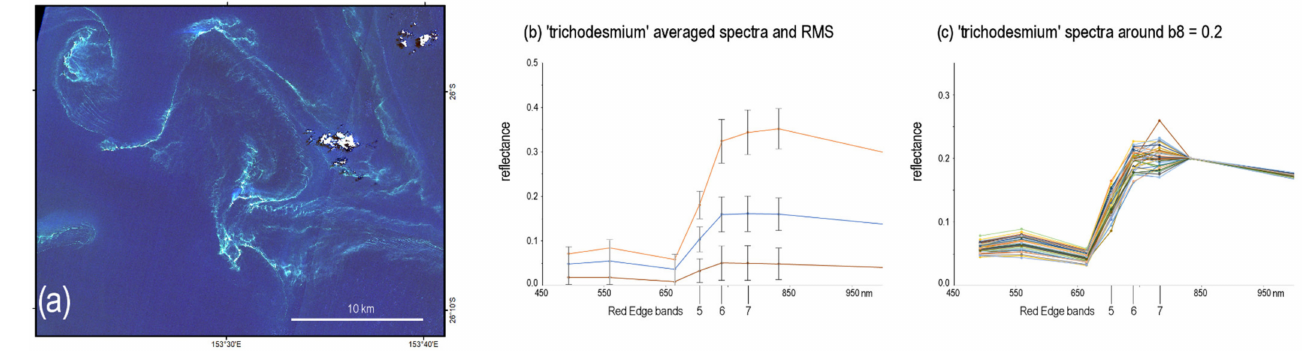
Figure 11. ( a ) “Trichodesmium” cyanobacteria bloom detected on 11 November 2020 off Gold Coast (QLD), eastern Australia (Sentinel-2 tile: T56JNS). ( b ) Averaged spectra and RMS around b8 = 0.35, b8 = 0.15 and b8 = 0.05. ( c ) Pixel spectra around b8 = 0.2 largely affected by ‘wiggling’.